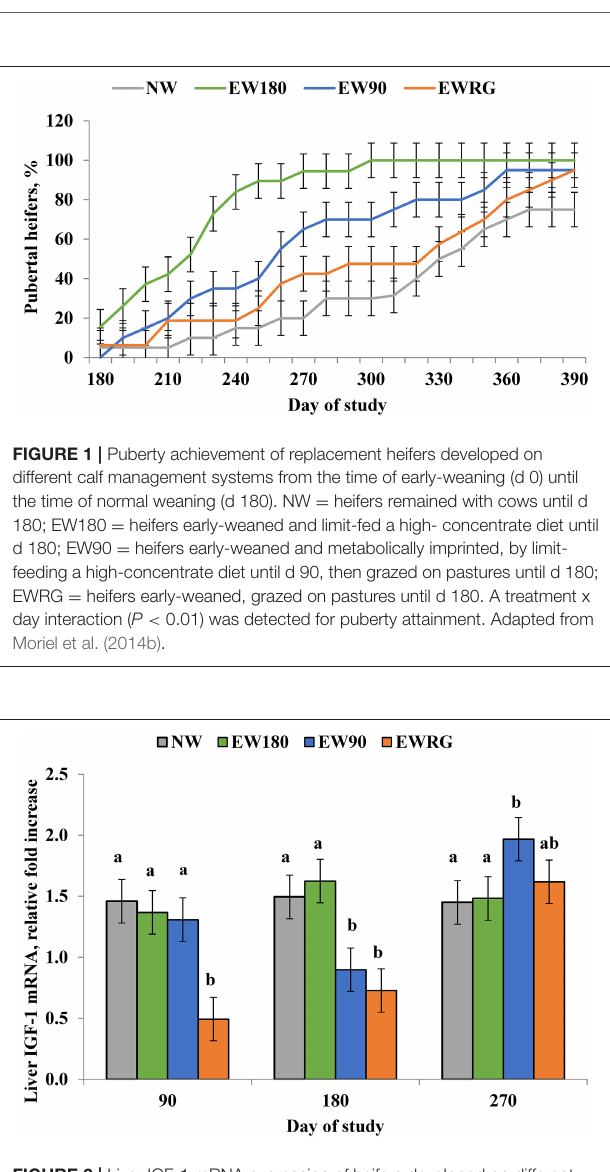
FIGURE 2 | Liver IGF-1 mRNA expression of heifers developed on different calf management systems from the time of early-weaning (d 0) until the time of normal weaning (d 180). NW = heifers remained with cows until d 180; EW180 = heifers early-weaned and limit-fed a high-concentrate diet until d 180; EW90 = heifers early-weaned and metabolically imprinted, by limit- feeding a high-concentrate diet until d 90, then grazed on pastures until d 180; EWRG = heifers early-weaned, grazed on pastures until d 180. Adapted from Moriel et al. (2014b). A treatment × day interaction was detected ( P < 0.01). a,b Within days, means without a common superscript differ ( P ≤